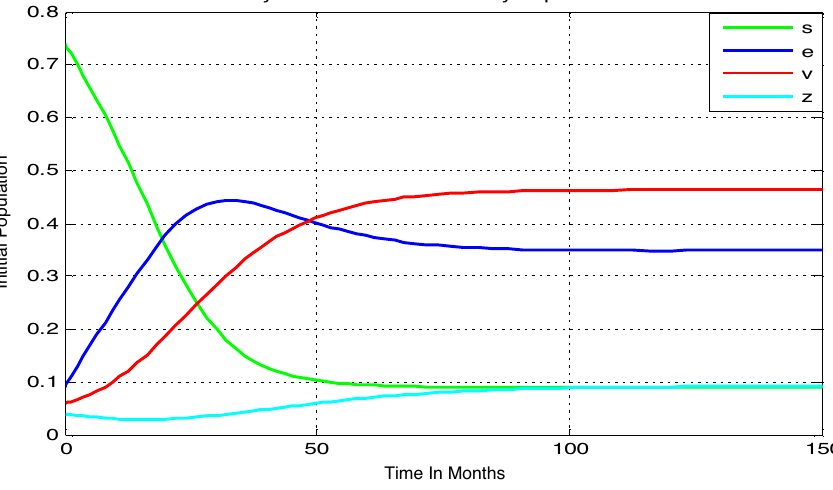
Figure 3. Local and global stability of the model animosity endemic equilibrium point whenever R 0 = 11.1.